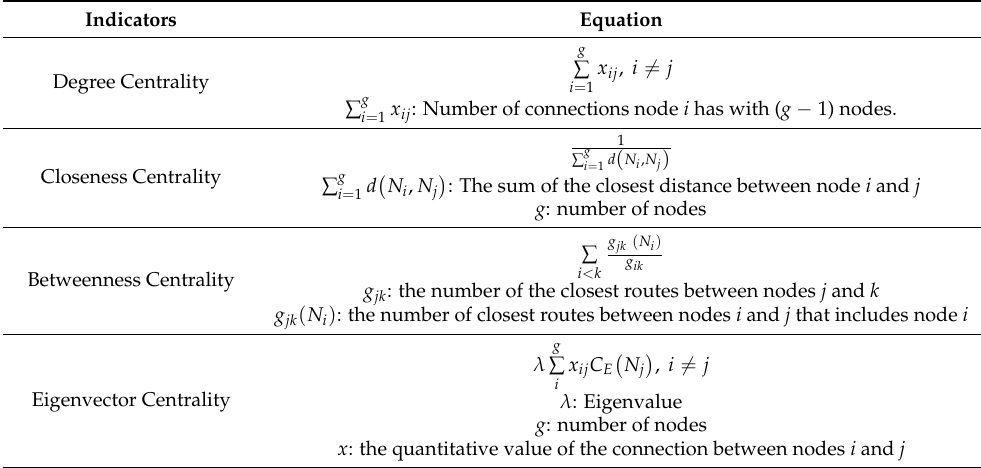
Table 1. The four indicators of